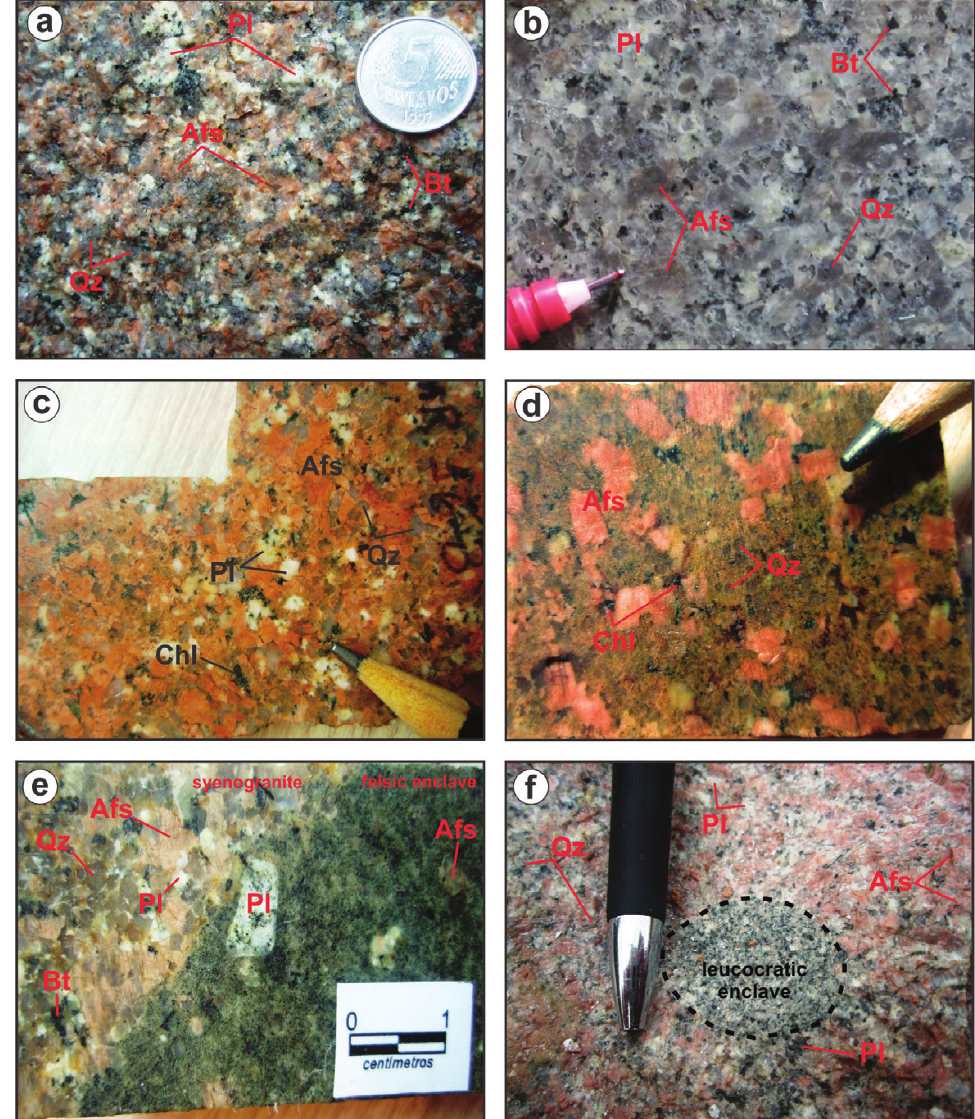
Figure 4 - Petrographic aspects of the Quiriri Pluton. (a) Massive, medium-grained, hololeucocratic, red-colored syenogranite of the Q1 facies, showing equi to inequigranular texture defined by quartz (Qz), plagioclase (Pl) and red-clouded alkali feldspar crystals (Afs), as well as biotite (Bt) as the main mafic mineral. (b) Massive, medium-grained, hololeucocratic, gray-colored syenogranite of Q2 facies. The inequigranular texture is defined by red to gray-colored alkali feldspar (Afs), minor plagioclase (Pl) and quartz (Qz) crystals and interstitial biotite (Bt). (c) Massive, medium to coarse grained, plagioclase-poor, hololeucocratic, red-colored syenogranite of Q3 facies. Large red-clouded alkali feldspar crystals (Afs) and minor quartz (Qz), plagioclase (Pl) and chlorite (Chl) pseudomorphs after biotite define an inequigranular texture. (d) Porphyritic syenogranite of Q4 facies showing tabular alkali feldspar (Afs) and globular quartz megacrysts (Qz) in a fine-grained matrix of poikilitic quartz enclosing plagioclase, chlorite (Chl) pseudomorphs after biotite and some late alkali feldspar crystals. (e) Detail of microgranular felsic enclave (right) composed of quartz, feldspars and chlorite pseudomorphs after biotite. Note euhedral plagioclase (Pl) and alkali feldspar (Afs) megacrysts that could represent xenocrysts from the syenogranite of Q1 facies (left) containing alkali feldspar (Afs), quartz (Qz), plagioclase (Pl) and biotite (Bt) in a inequigranular texture. (f) Detail of leucocratic enclave displaying mainly plagioclase and interstitial chlorite and epidote (dark colors) replacing primary biotite, within the inequigranular, red-colored inequigranular Q1 syenogranite showing alkali feldspar (Afs), plagioclase (Pl), quartz (Qz) and interstitial biotite